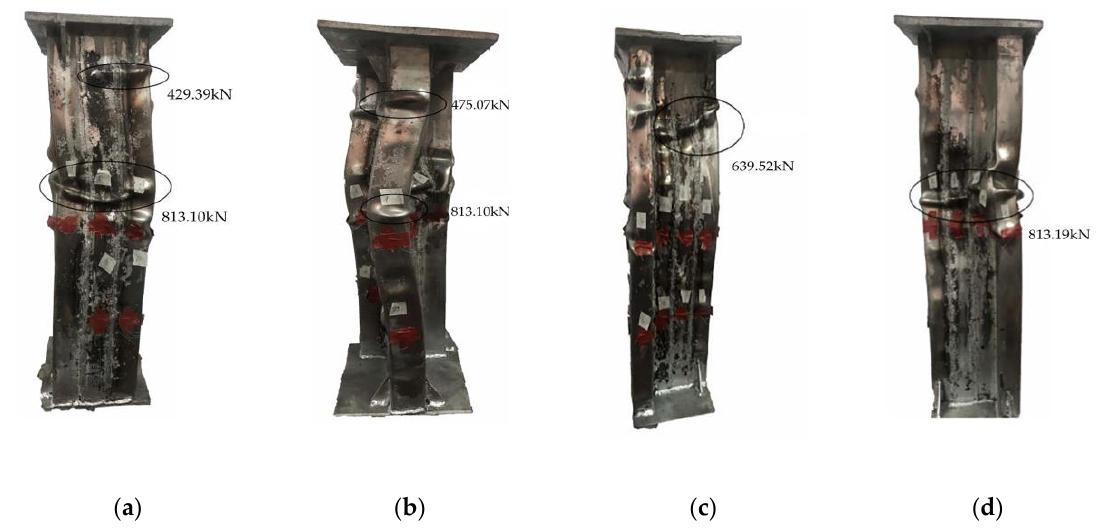
Figure 5. Deformation pattern of ( a ) the third surface; ( b ) the first surface; ( c ) the second surface; ( d ) the fourth surface of the TA6-600 test specimen.